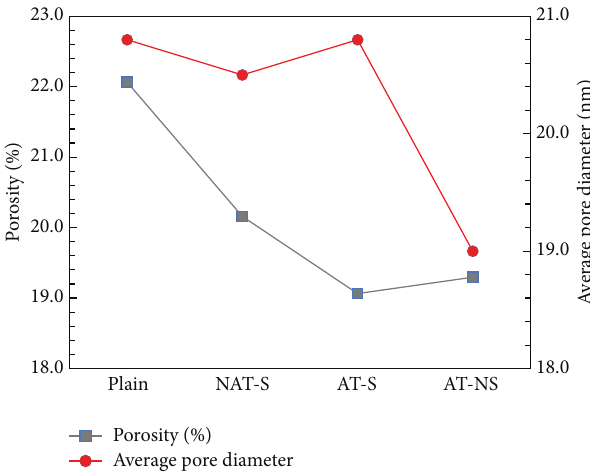
Figure 9: The results of MIP analysis.